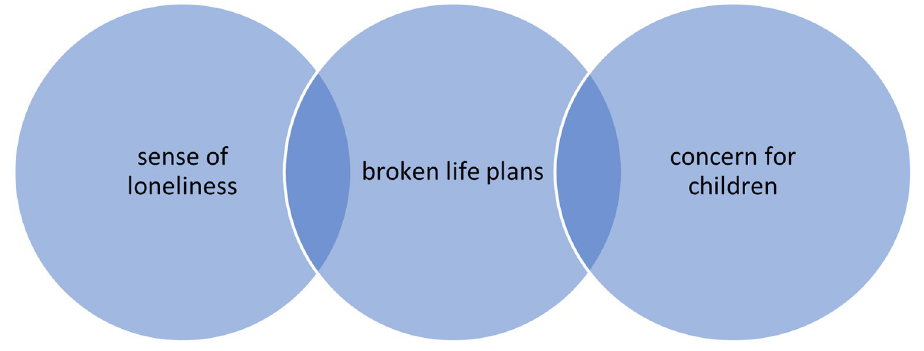
Fig 2. States of mind and